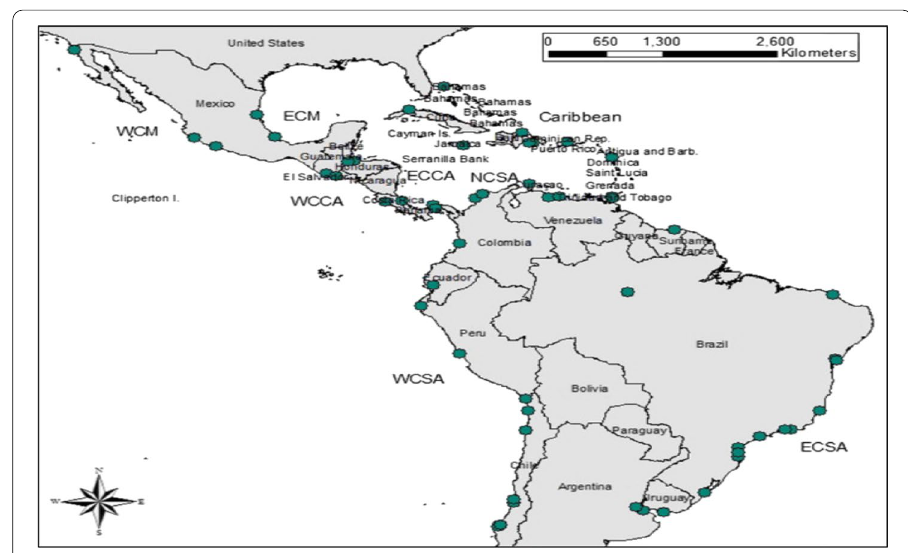
Fig. 2 Map shows Latin America’s and the Caribbean port system (TEU). Source : Wilmsmeier and Monios